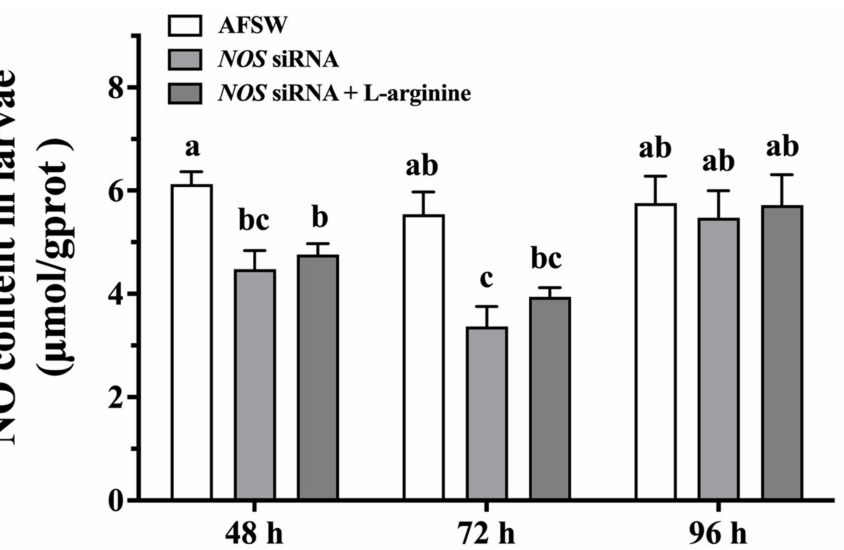
Figure 6. NO content in the larvae at different timepoints after NOS siRNA transfection. Values represent mean ± SEM ( n = 800), and bars with different letters indicate significant differences ( p <